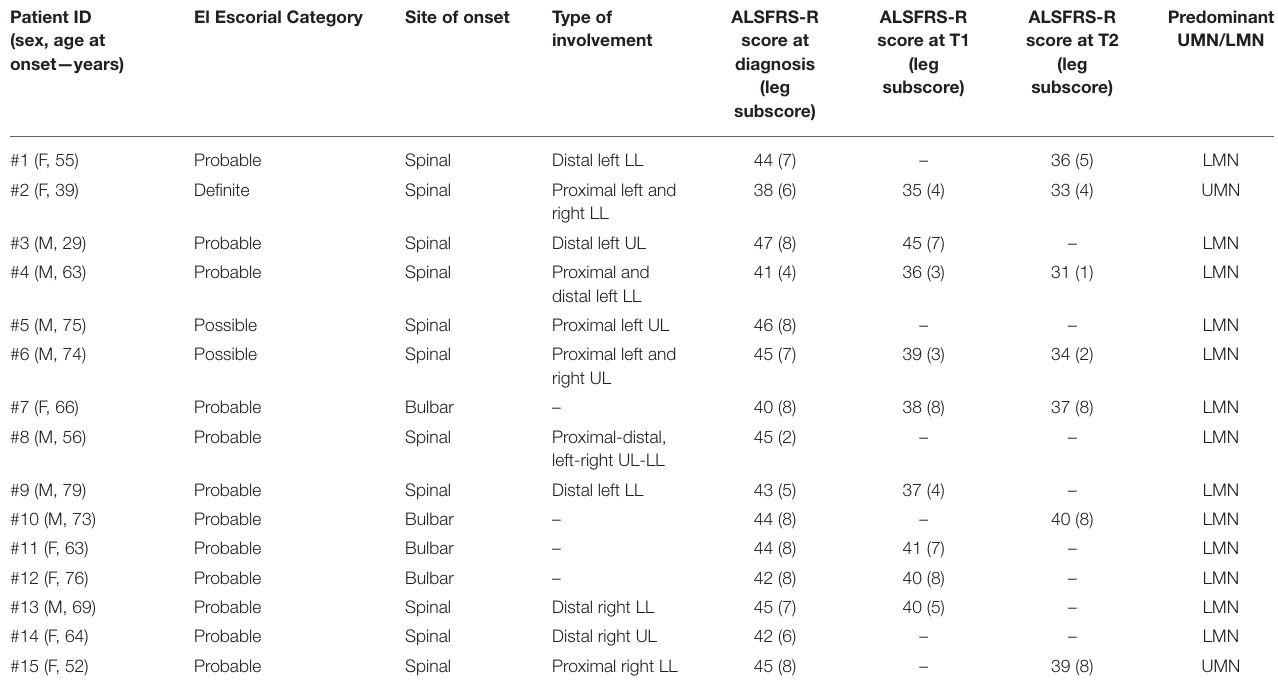
TABLE 1 | Clinical and epidemiological data. Patient ID (sex, age at